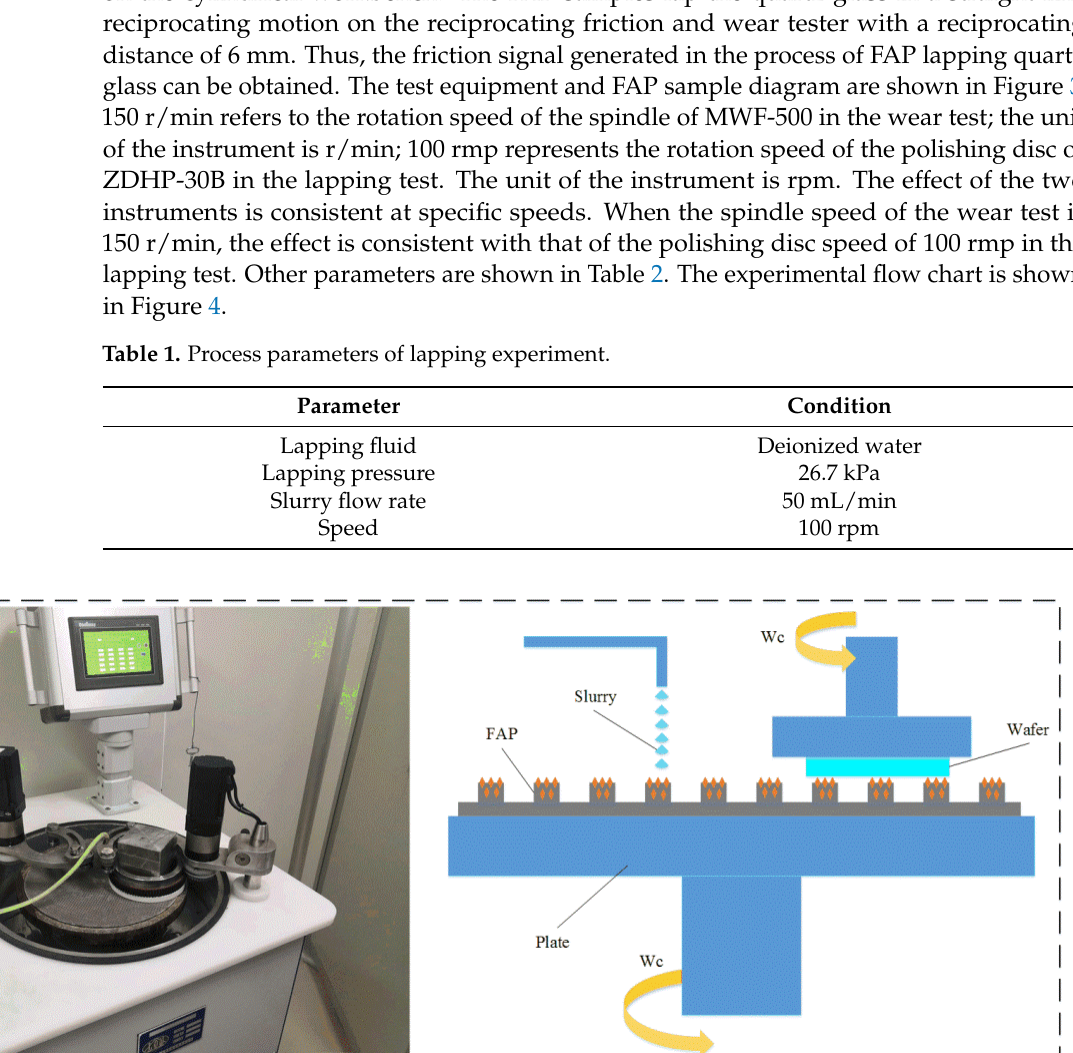
Table 1. Process parameters of lapping experiment.